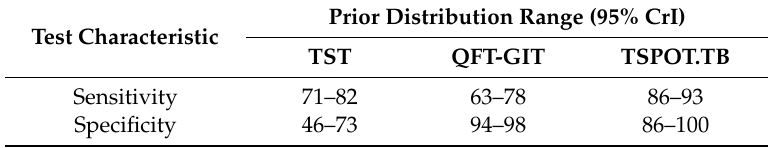
Table 1. Prior information on sensitivity and specificity of tuberculin skin-test and interferon-gamma-release assays